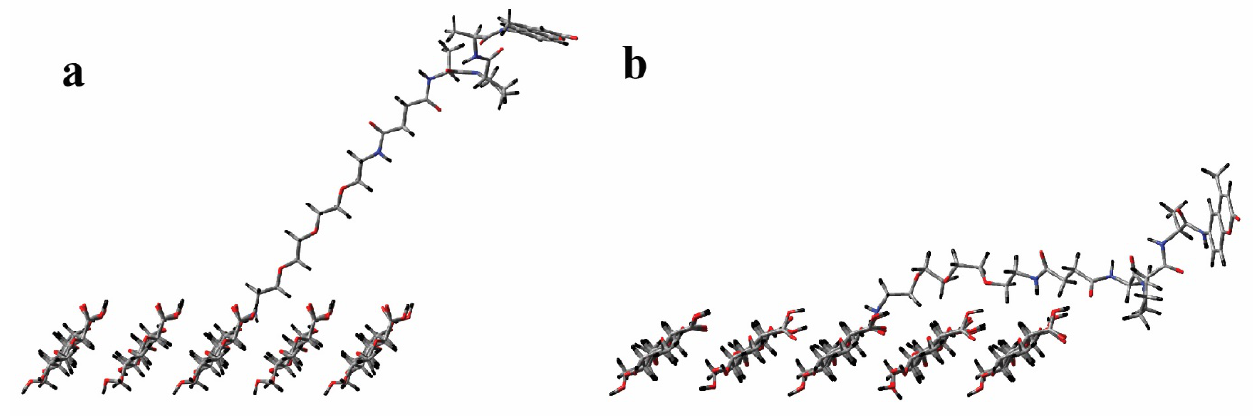
Figure 5. Side view of the optimized peptide–cellulose conjugates (tNFC-Pep) for the ( a ) (1 − 10) crystal plane and the ( b ) (110) crystal plane.